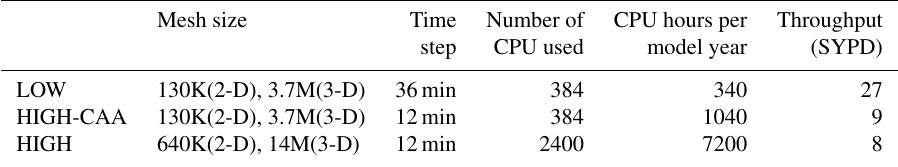
Table 2. Summary of computational cost and performance. Mesh size Time Number